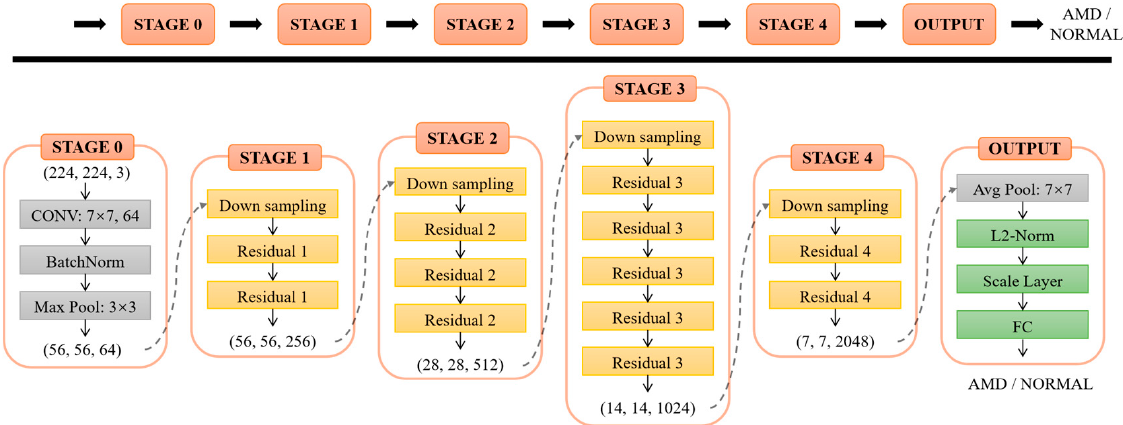
Figure 3. The architecture of the ResNet-50 used. L2-constrained is implemented via the L2-Norm layer and the Scale layer in the OUTPUT module.